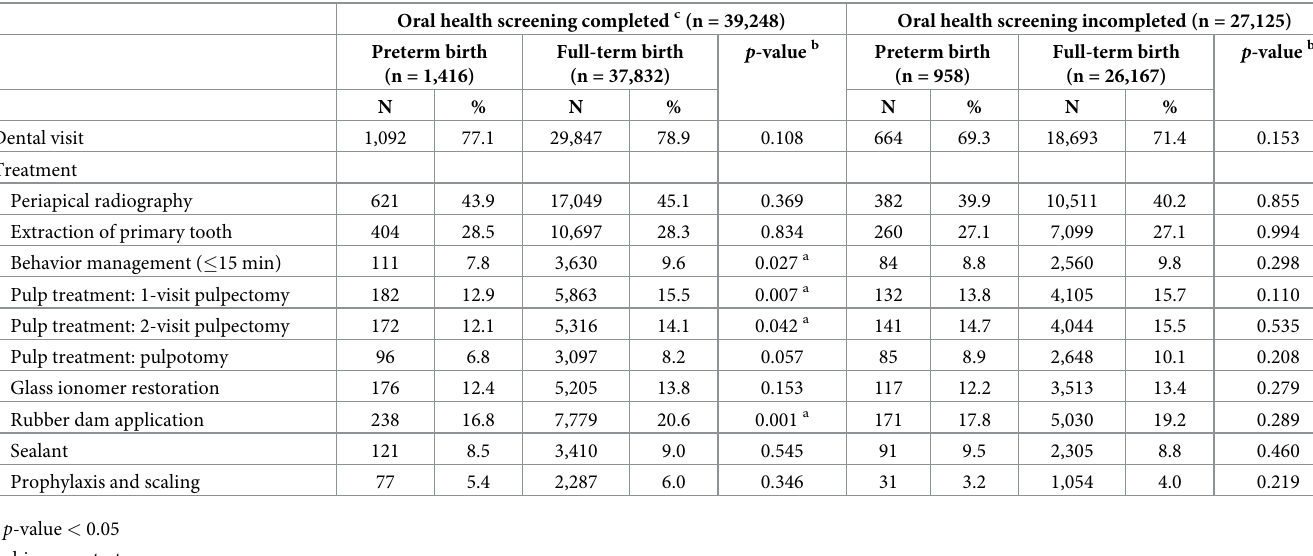
In this study, the association between dietary habits and oral characteristics of preterm chil- dren was evaluated using a nationwide database. Full-term babies usually had normal weight at birth, and preterm babies usually had low body weight. Duration of NICU stay was longer, Table 5. Comparison of dental treatments according to oral health screening